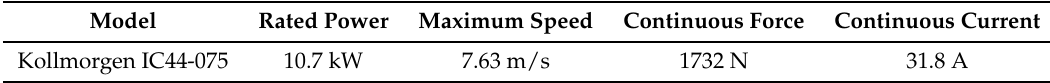
Table 1. Linear motor specifications.